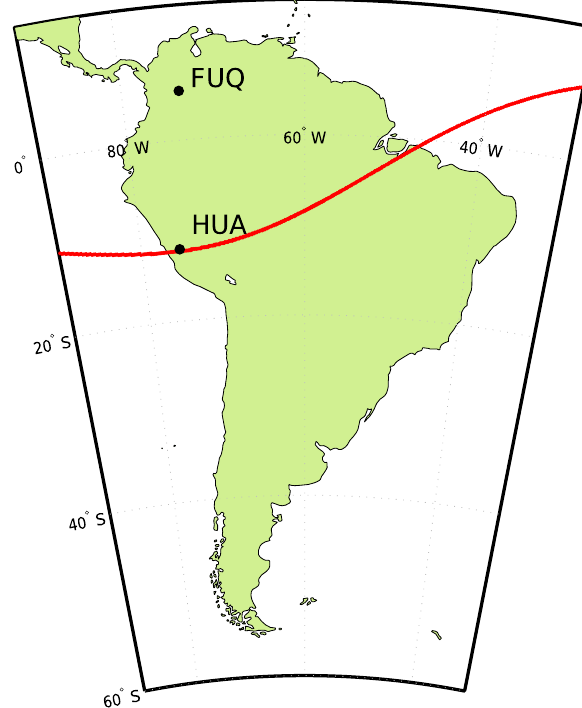
Figure 1. The locations of the Huancayo (HUA) and Fúquene (FUQ) observatories are marked with black dots in this figure. The red line denotes the dip